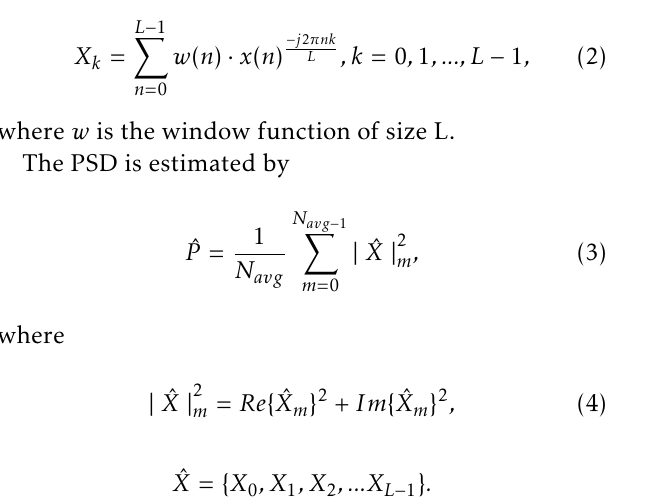
Figure 2. Block diagram for PSD